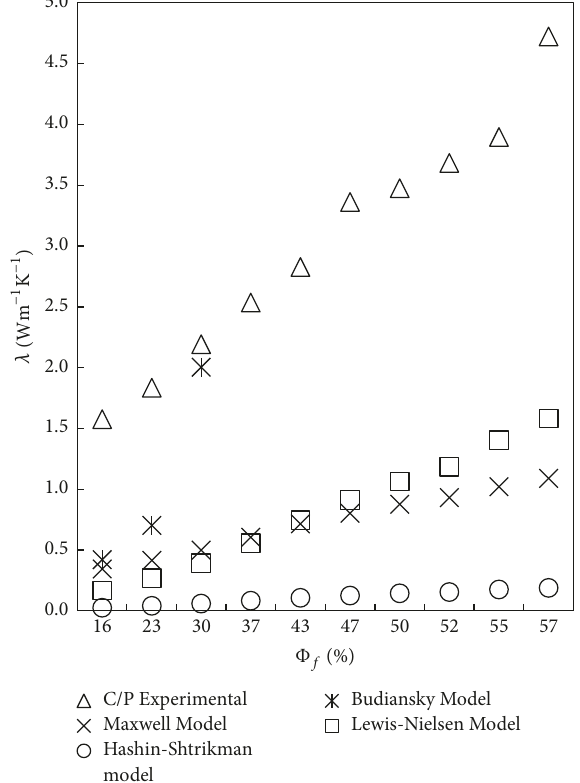
Figure 4: Variation of thermal conductivity of composite versus volume content of filler and comparison of the theoretical